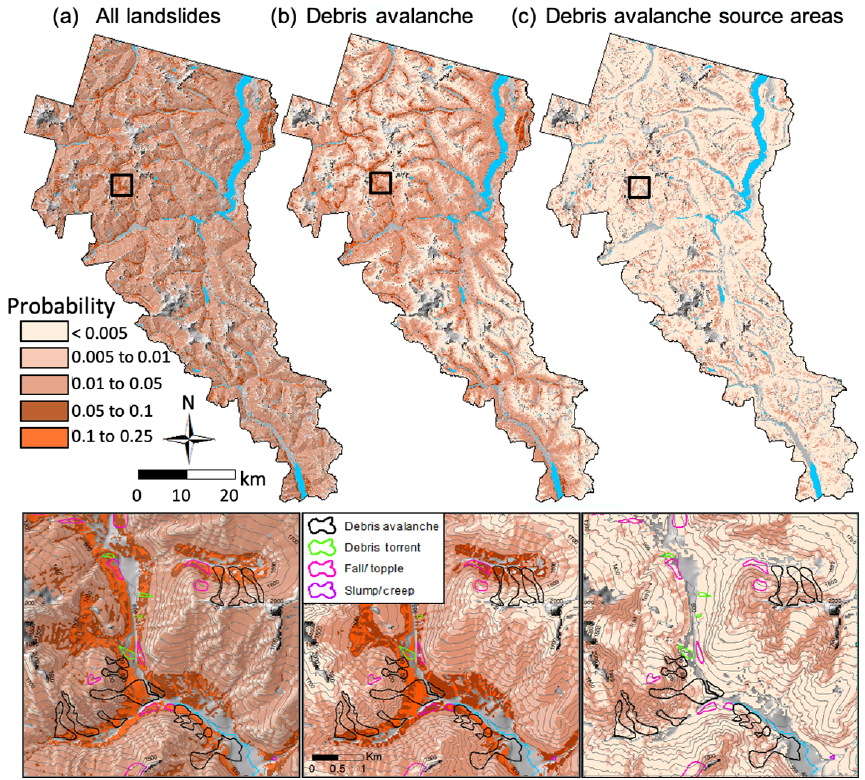
Figure 7. Maps of the probability of a landslide impact derived from an empirical model based on (a) all landslide types, (b) debris avalanches, and (c) source areas of debris avalanches overlain on a hillshade raster. Black boxes indicate closeup areas shown below with overlain landslide types and 100m contours. Gray areas excluded from the analysis show river valleys and glaciated